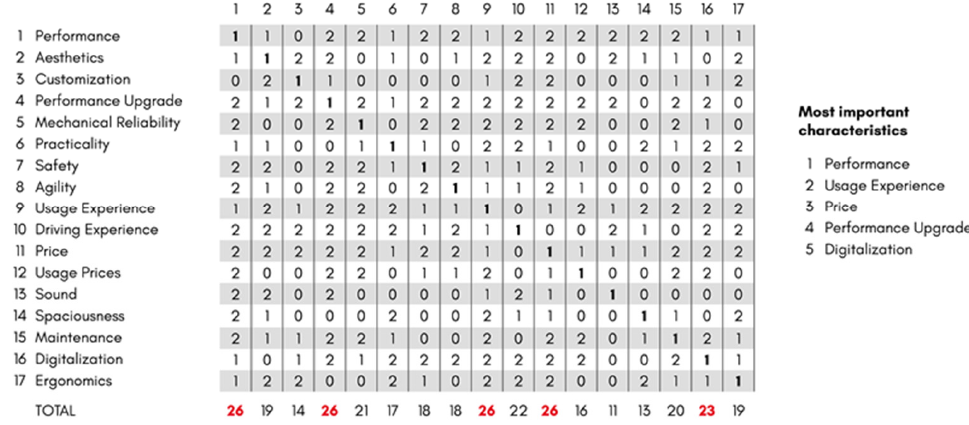
Figure 8. Matrix of dependence/independence. Considering the requirements extracted from both matrices, the vehicle is supposed to be all about the performance and the excitement of being able to control the vehicle on the road. Major attention also goes to the driver and the overall driving experience.